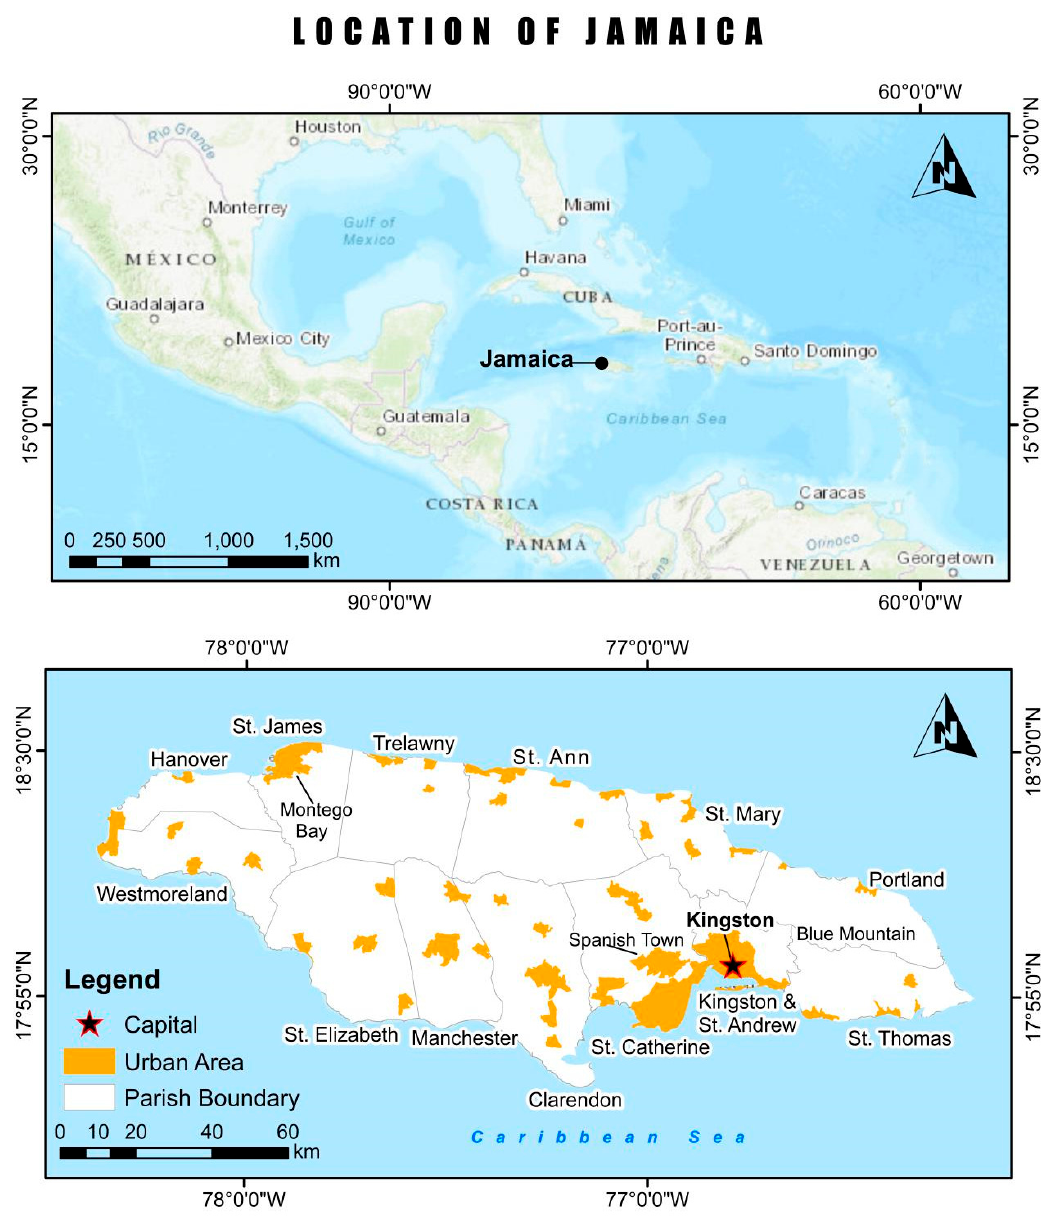
Figure 1. Location of Jamaica [27]. Urban area based on the 2011 Enumeration Districts from the Statistical Institute of Jamaica (STATIN)